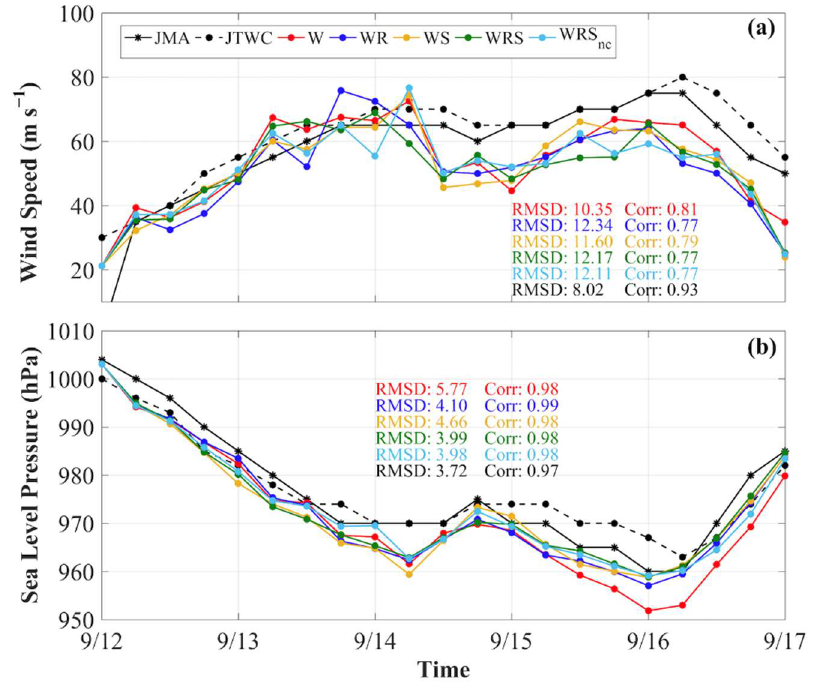
Figure 4. Typhoon intensity simulation. ( a ) Maximum sustained wind speed (V max ; m s − 1 ); and ( b ) minimum sea level pressure (P min ; hPa) at the TC center. JMA (bold black line), JTWC (dashed black line), W (red), WR (blue), WS (orange) and WRS (green). The same colors are used for RMSD and R 2 , which are calculated relative to JMA data. The dots represent data between 00:00 12 September and 00:00 17 September, with intervals of 6 h.